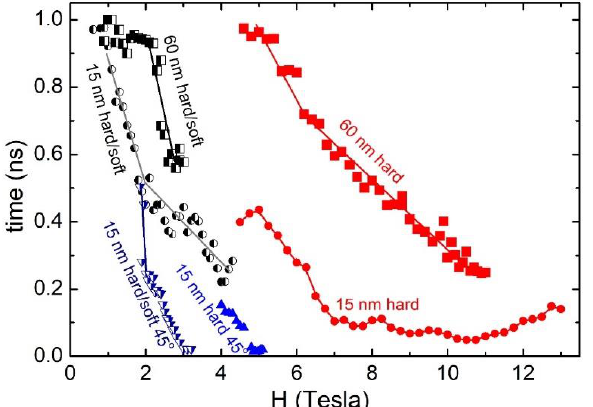
Figure 7. Summary of minimum magnetization reversal time using MAS, as a function of the applied reversed field, for different CoPt (hard) and CoPt/Co 3 Pt (hard/soft) nanostructures.